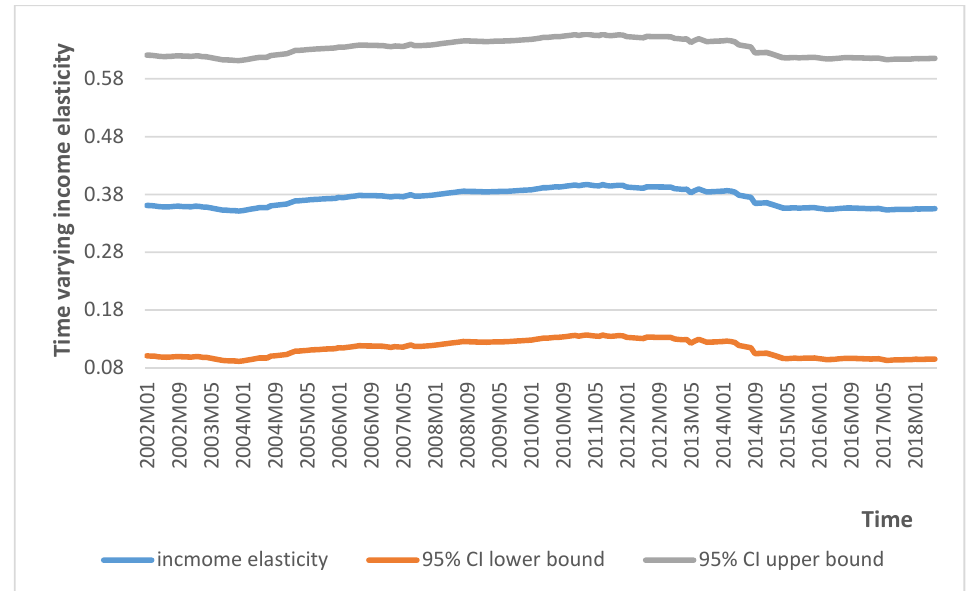
Energies 2020 , 13 , x FOR PEER REVIEW Table 7.